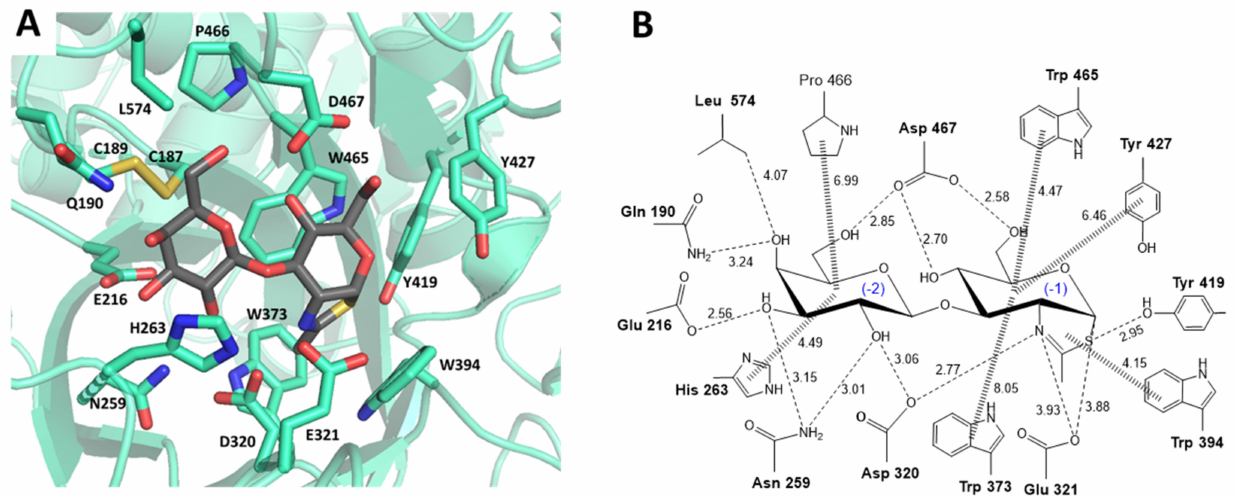
Figure 2. ( A ) X-ray structure of Bifidobacterium bifidum lacto- N -biosidase (LnbB) complexed with LNB-thiazoline inhibitor (PDB ID: 4JAW). First shell residues shaping the donor subsites in the active site are shown in sticks. ( B ) Enzyme-ligand interactions map at donor subsites (-2, -1). Amino acid residues mutated in this work are in